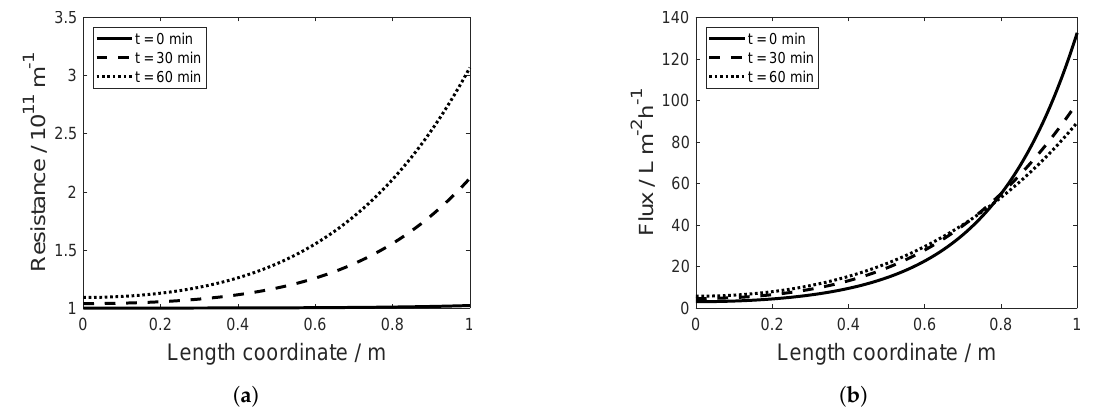
Figure 3. Transient effect of membrane fouling on local resistance R ( t , x ) ( a ) and flux profile J ( t , x ) ( b ) for reference